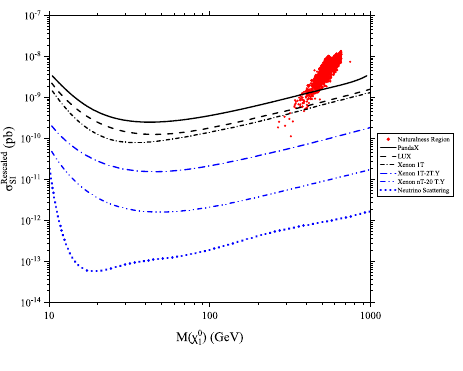
Figure 1 . Depiction of the -SU(5) D-brane inspired naturalness region, represented by the small F red points. The LUX, PandaX-II, and XENON100 dark matter direct detection upper limits on spin-independent neutralino-nucleus cross-sections are sketched and labeled, as well the neutrino scattering floor. The 2900 points here satisfy the constraints M ( g ) 1 . 6 TeV, 124 m h ∼ ≥ ≤ ≤ 128 GeV, Ω h 2 0 . 1221, ∆ M ( t 1 , χ 0 ) 10 GeV, and χ 0 > 80% Higgsino. The cross-sections σ Rescaled 1 1 SI ≤ ≤ are rescaled in accordance with eq. (3.1). e e e e